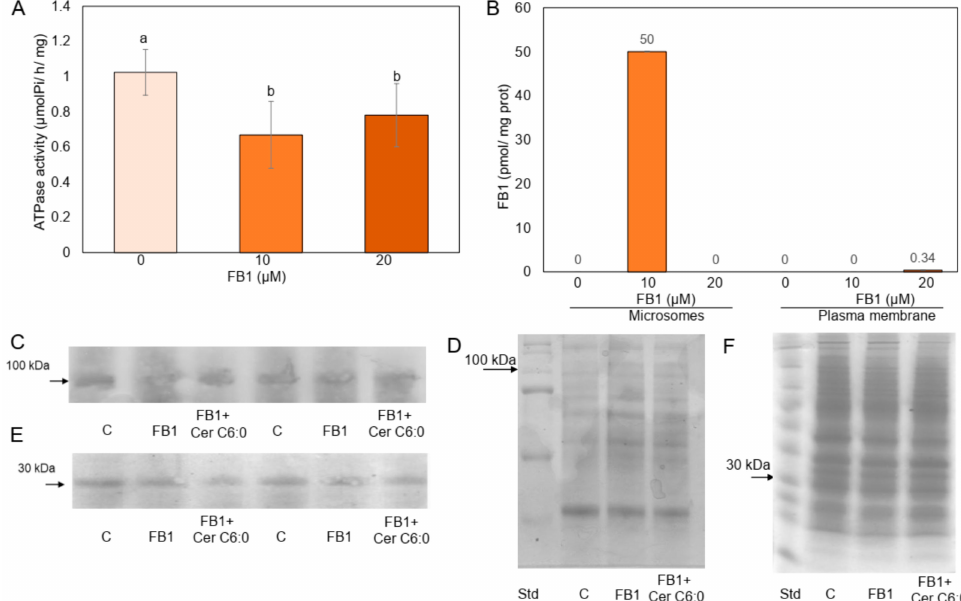
Figure 1. E ff ect of Fumonisin B1 (FB1) on the plasma membrane (PM) H + -ATPase activity, mycotoxin content, and H + -ATPase and 14-3-3 protein levels in the PM. Maize embryos were imbibed with or without FB1 at the indicated concentrations during 24 h. Then, microsomes or PM were isolated and ATPase activity, FB1 or H + -ATPase, and 14-3-3 protein levels were determined. ( A ) Five to 10 µ g of PM protein were added to a reaction mixture to measure ATP hydrolysis in the absence or presence of FB1 . ( B ) FB1 was determined in microsomes or PM as described under Experimental Procedures. The amount of mycotoxin in microsomes was of 50 ± 17 pmol / mg protein when embryos were exposed to 10 µ M FB1 and of 0.34 ± 0.03 pmol / mg protein in the PM when embryos were exposed to 20 µ M FB1. No mycotoxin was detected in both membranes when the embryos were exposed at the other concentrations shown. Data are the means ± SD of three independent experiments with three di ff erent membrane preparations. Welch’s t -test and two-way ANOVA followed by Bonferroni’s multiple comparisons test were performed using GraphPad Prism version 8.0 for Windows, GraphPad Software (San Diego CA). ( C ) E ff ect of FB1 on the PM levels of H + -ATPase. Twenty-five µ g of PM protein from maize embryos imbibed in the absence or presence of 10 µ M FB1 or to 10 µ M FB1 and Ceramide 6:0 as indicated, were subjected to western blot for PM H + -ATPase detection. ( D ) Replicate samples in the same gels were Coomassie blue stained. Experiment is representative of 10 experiments carried out with 10 independent membrane preparations exposed to FB1 or eight exposed to Ceramide 6:0. Density recordings of the bands were done and the values analyzed by the ANOVA test ( P = 0.8 > α = 0.05). ( E ) E ff ect of FB1 on the PM levels of 14-3-3 protein. Twenty-five µ g of PM protein from maize embryos imbibed in the absence or presence of 10 µ M FB1 or to 10 µ M FB1 and Ceramide 6:0 as indicated, were subjected to western blot for 14-3-3 protein detection. ( F ) Replicate samples in the same gels were Coomassie blue stained. The experiment is representative of 16 experiments carried out with 10 independent membrane preparations exposed to FB1 or 10 exposed to Ceramide 6:0. Density recordings of the bands were done and the values analyzed by the ANOVA test ( P = 0.1 > α = 0.05). Cer C6:0: Ceramide